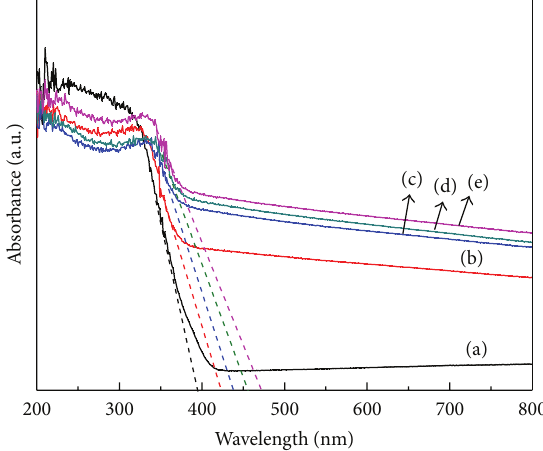
Figure 4: UV-vis diffuse reflectance spectra of P25 (a), C/TiO 2 (b), and Pt-C/TiO 2 composites (c)–(e). The content of Pt is 0.1 wt% (c), 0.4 wt% (d), and 0.6 wt% (e),